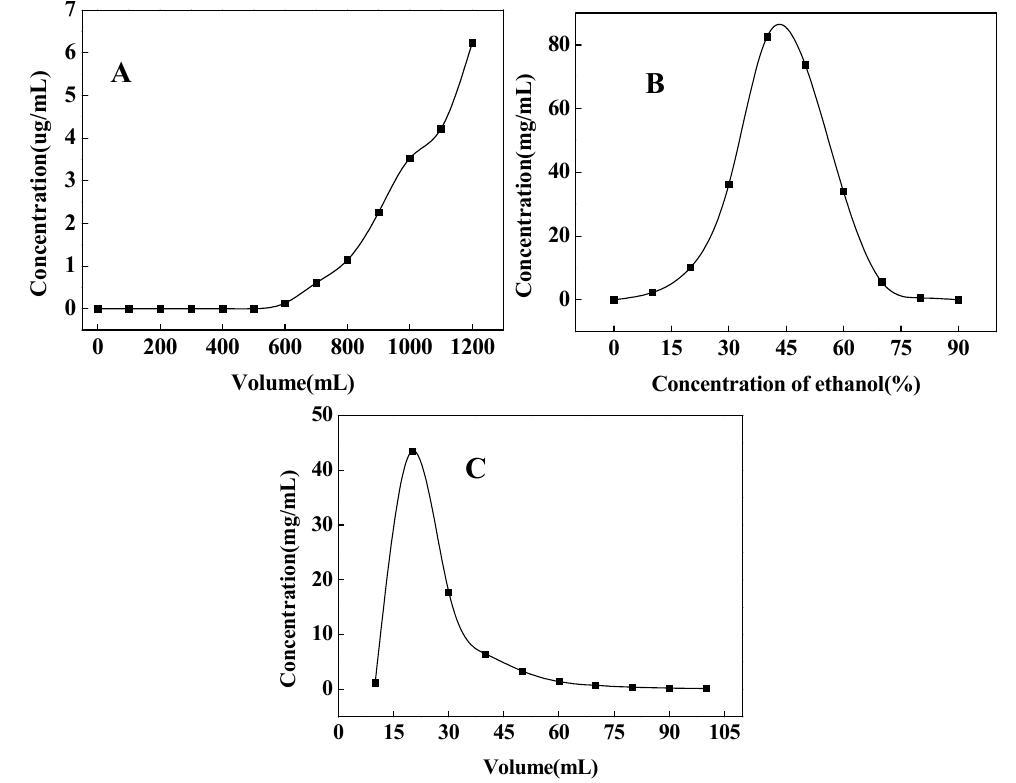
Figure 2. Dynamic leakage curves ( A ), dynamic desorption curves of poncirin by gradient elution ( B ), and isocratic elution ( C ) on column packed with D101 resin. Initial poncirin concentration in feed solution: 0.05 mg/mL; isocratic elution solution: 60% ( v / v ) ethanol; both adsorption and desorption flow rate: 1.0